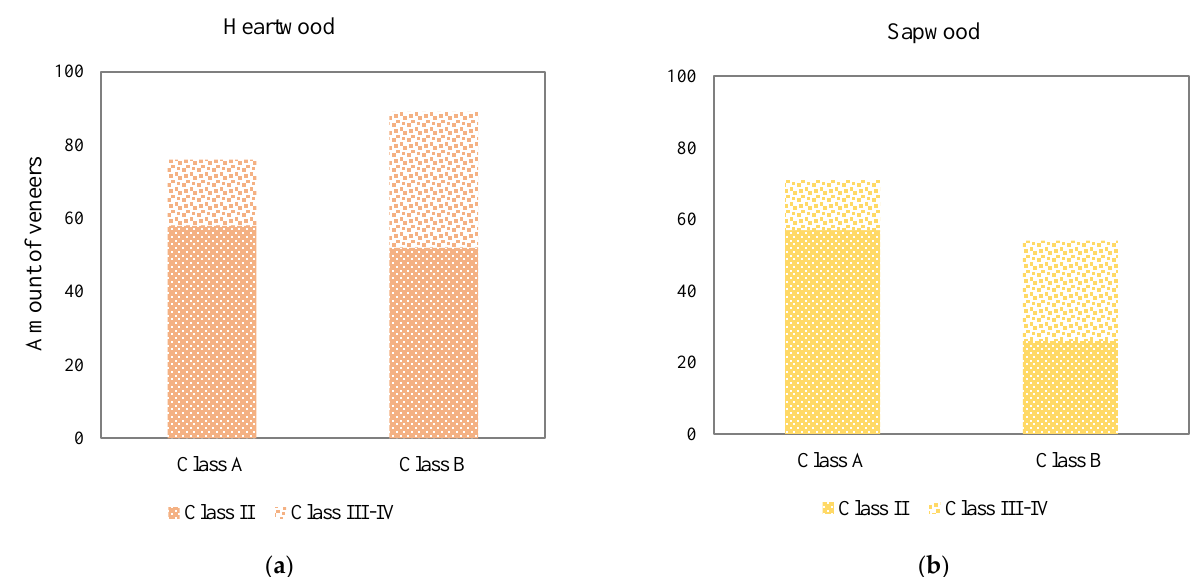
Figure 9. Distribution of veneers according to their sorting class by stiffness profile: ( a ) heartwood, ( b ) sapwood.